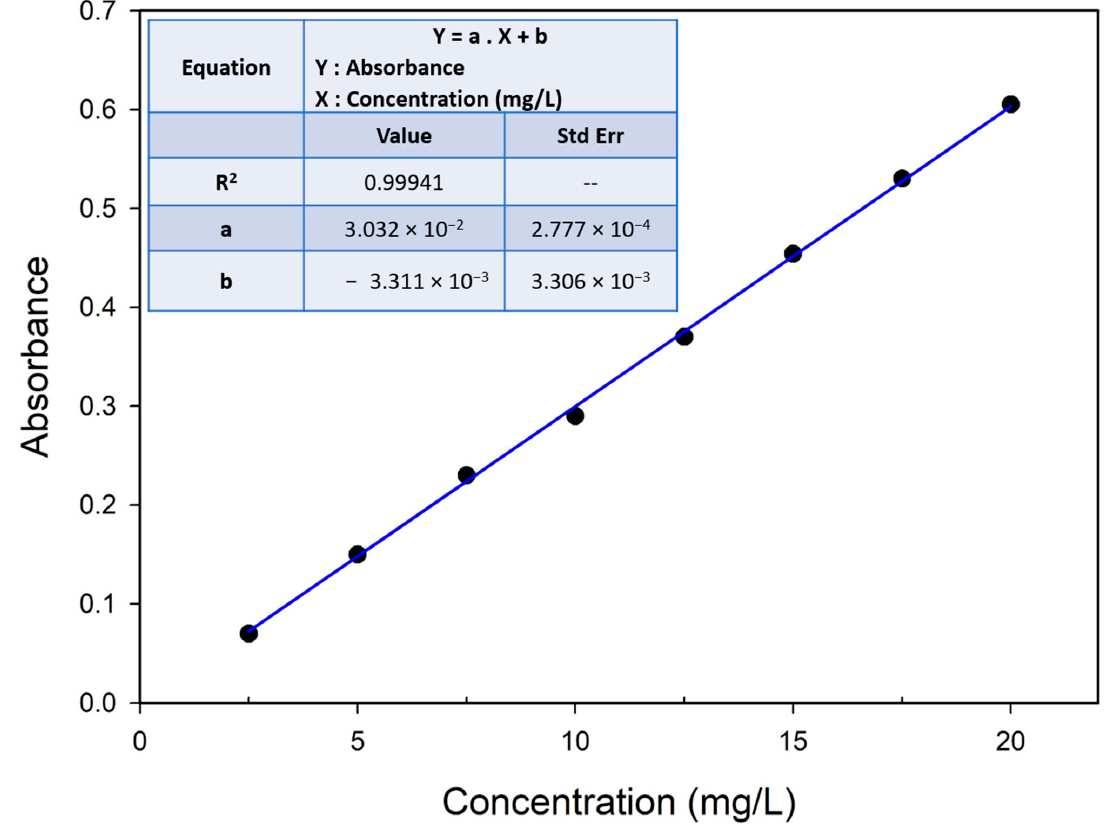
Figure A5. Calibration curve in absorbance of ibuprofen in a 0.1 M hydrochloric acid solution.